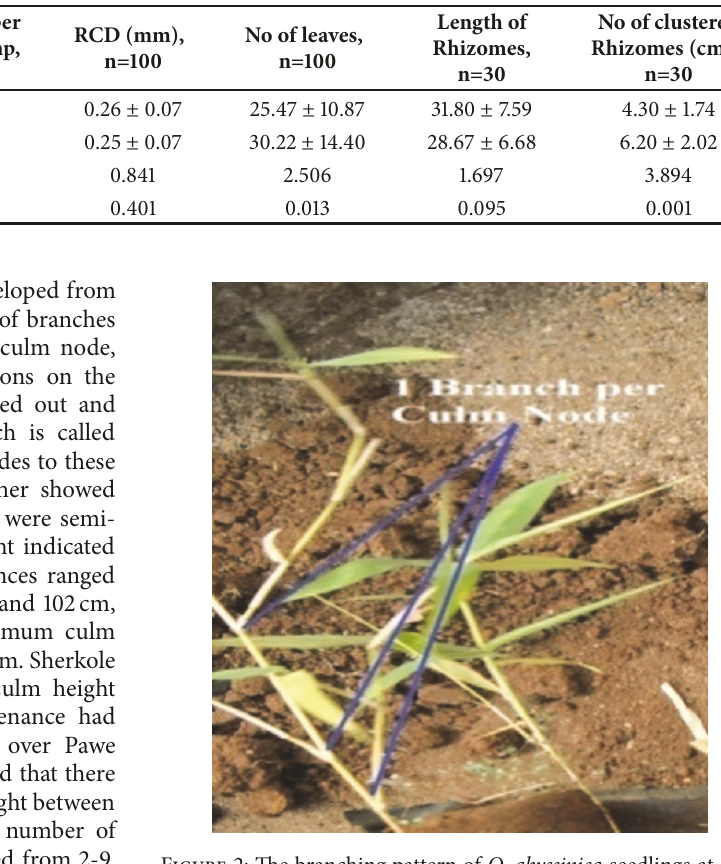
Figure 2: The branching pattern of O. abyssinica seedlings at each culm node ( source: photo taken by Tinsae Bahru